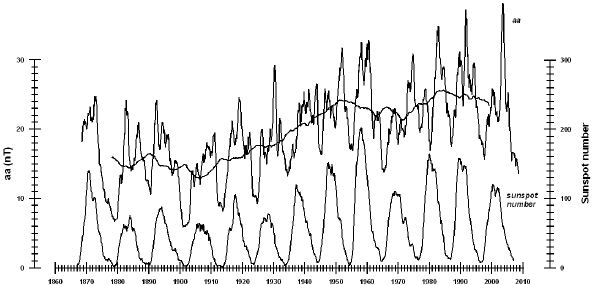
Fig. 2. Long-term variations of aa indices (12-month and 20-year running averages; scale on the left) and of sunspot numbers (12- month running averages; scale on the right) from 1868 until